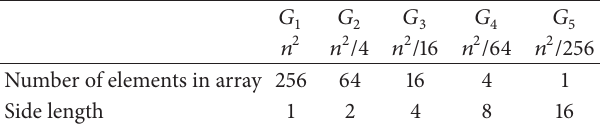
Table 1: Relationship between image’s size and array’s length. 𝐺